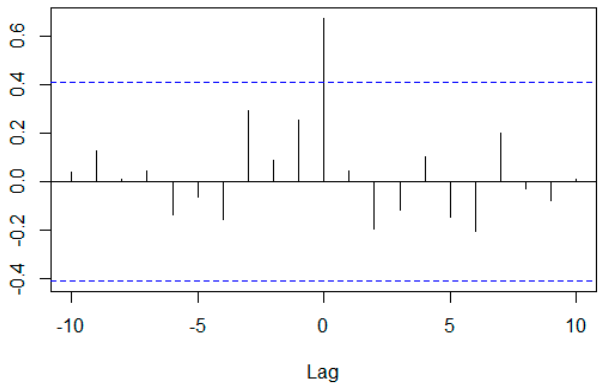
Figure 3. Cross-correlation coefficient between the average CAR of the whole sample group and the average CAR of the camera group for Evaluation period: 2007–2008, Event period: 2010–2012.